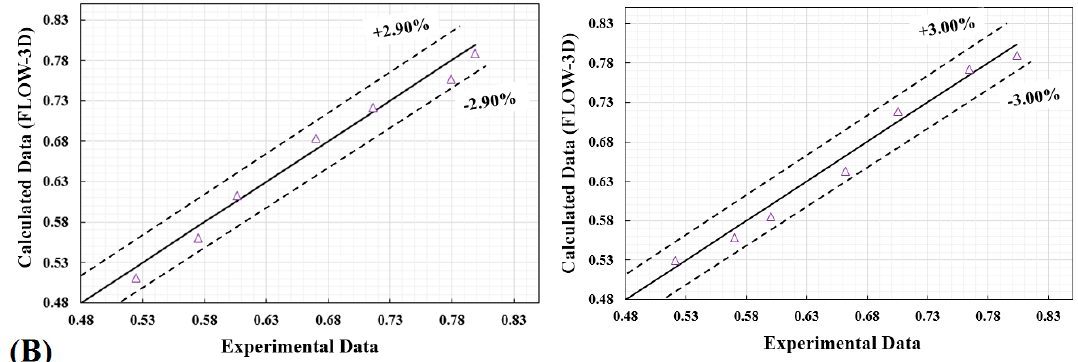
Figure 6. ( A ) Comparison of discharge coefficient obtained from numerical solution with experimental data; ( B ) Determination of error percentage.